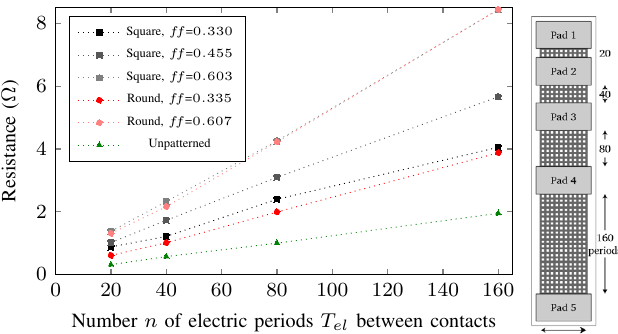
Fig. 4. Degradation ratio of the lateral resistance of the TCO layer for different patterns (patterns are simulated with T el equal to 500 nm).